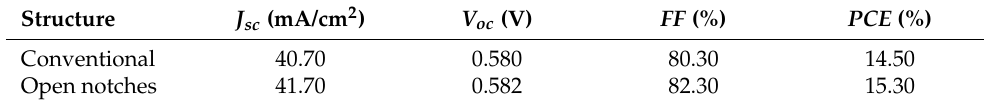
Table 1. PV parameters of the conventional and the partially filled notches microstructures.